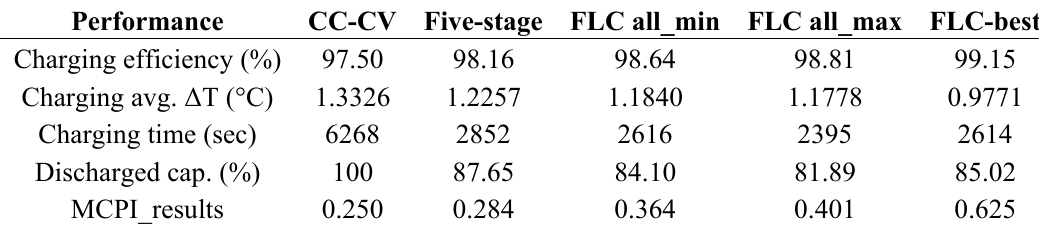
Table 12. Comparison of five tested algorithms.